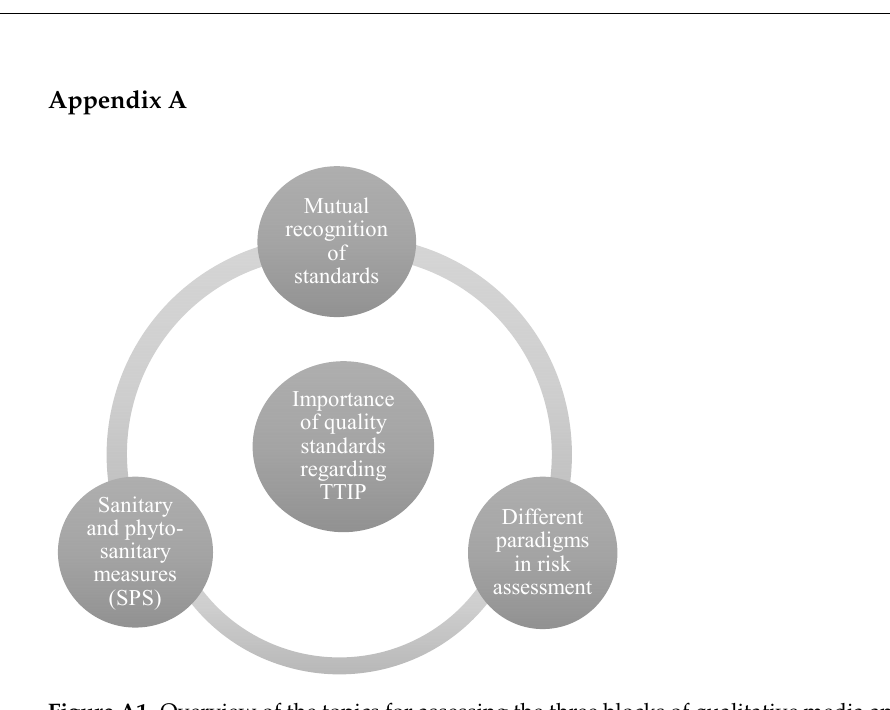
Figure A1. Overview of the topics for assessing the three blocks of qualitative media analysis. Source: own description.